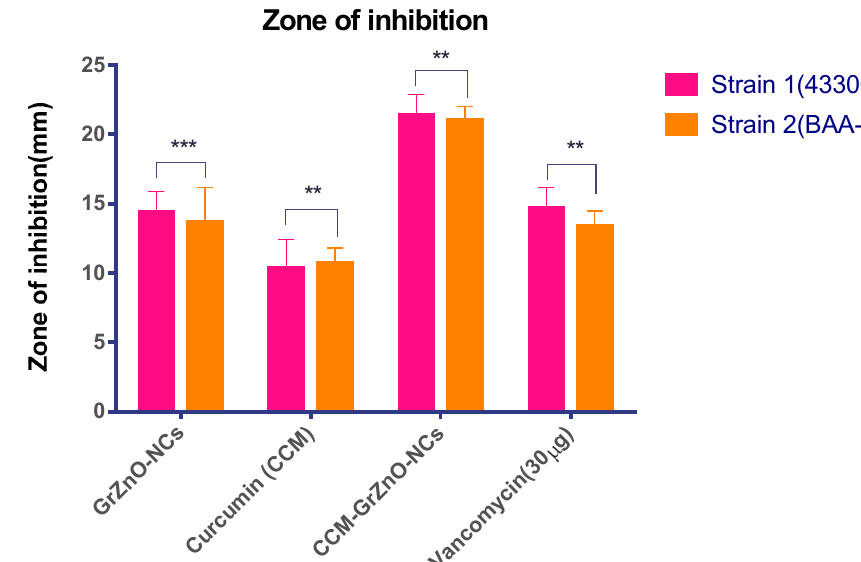
Figure 4. Antibacterial activity of as-synthesized CCM-GrZnO-NCs based formulations. Zone of inhibition as a measure to establish the antibacterial potential of various GrZnO-NCs formulations against M.R.S.A. strains. Experiments were performed in triplicates, and results are shown as mean ± S.D.; ** p ≤ 0.01; *** p ≤ 0.001